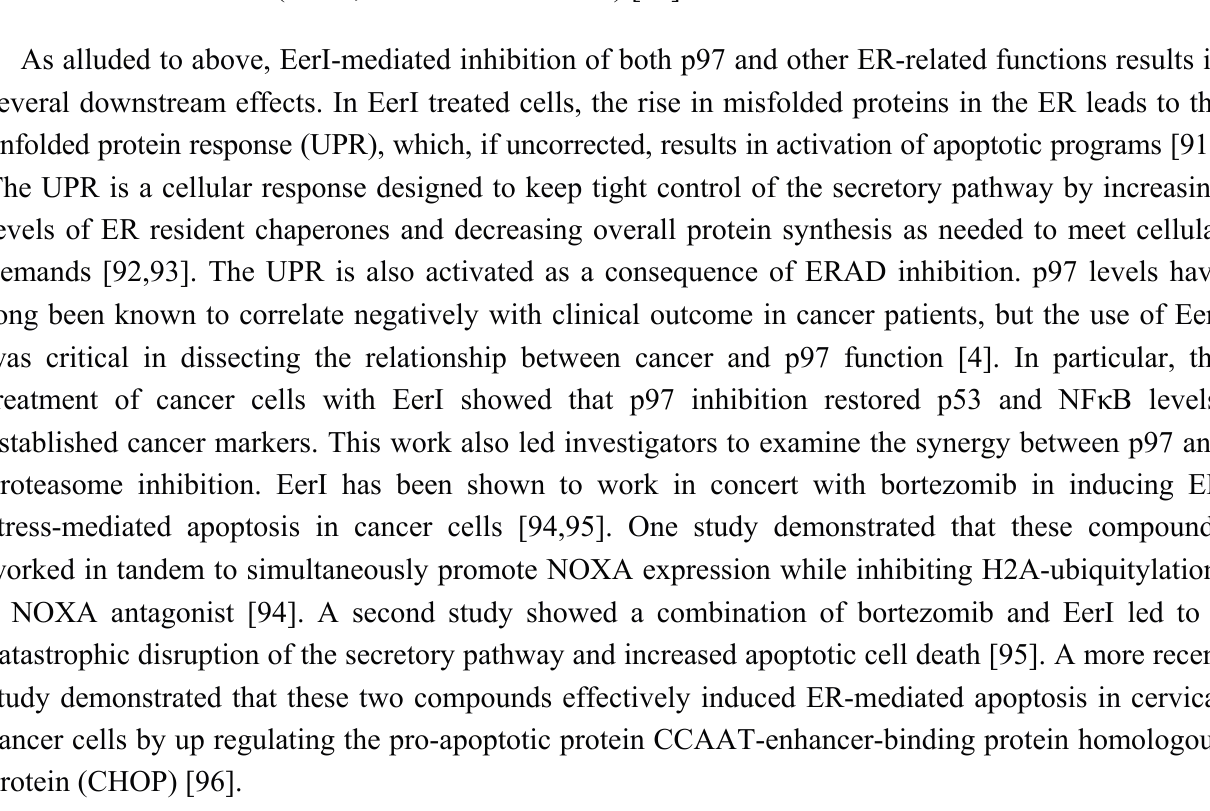
Figure 3. Structures of the current collection of p97 inhibitors. Compounds can be sorted by classes as given by unselective agents (green), selective agents (red), natural products (blue) and a kinase inhibitor that causes misregulation of p97 by blocking phosphorylation of the C-terminus (violet; not discussed in text)